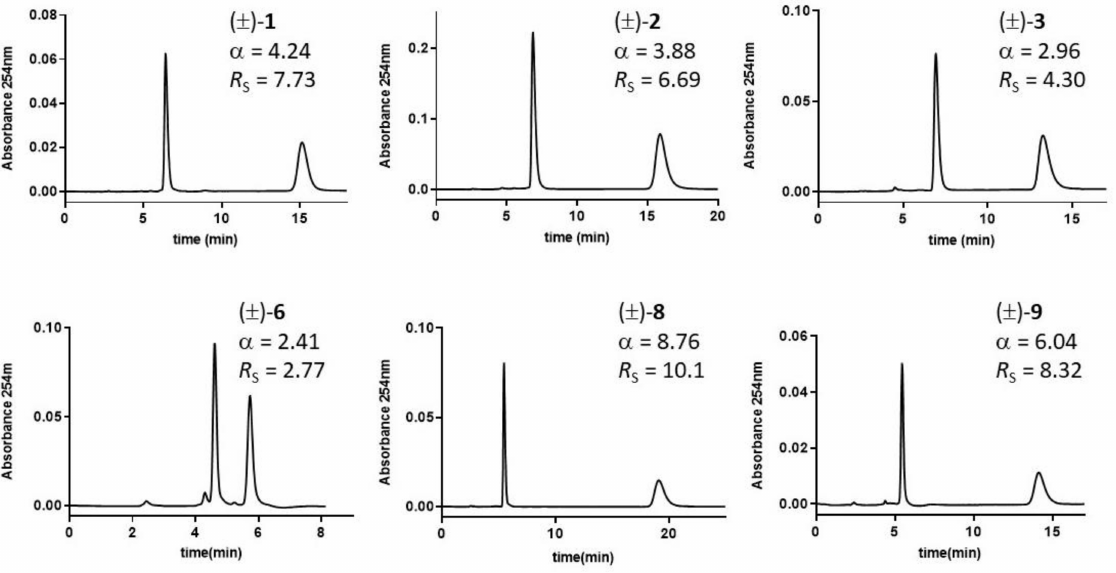
Figure 4. Chromatograms of DHP analytes on Chirobiotic TM TAG column. Mobile phase: MeOH 100%, v / v ; flow rate: 0.7 mL · min − 1 ; room temperature; UV detection: 254